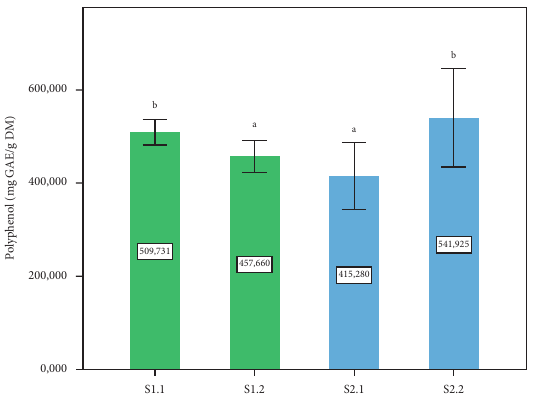
Figure 2: Total polyphenols content of the P. lentiscus L. leaves at different altitudes. Data are means of three replicates. Vertical bars represent the standard deviation of the mean. Values not sharing a common letter indicate a significant difference at p ≤ 0 . 05, based on the SNK test. GAE: gallic acid equivalent. DM: dry matter. S: site, S1.1 � 1400m, S1.2 � 1120, S2.1 � 780 m, S2.2 � 720m.